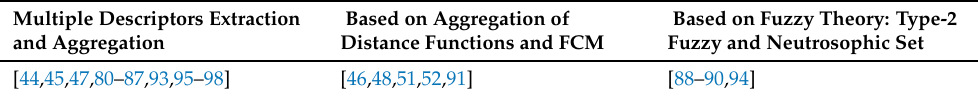
Table 3. Summary of papers by